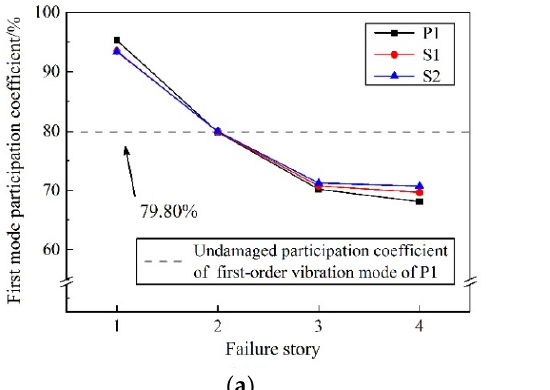
Figure 14. First-mode participation coefficient of residual structure. ( a ) 4-story; ( b ) 10-story.